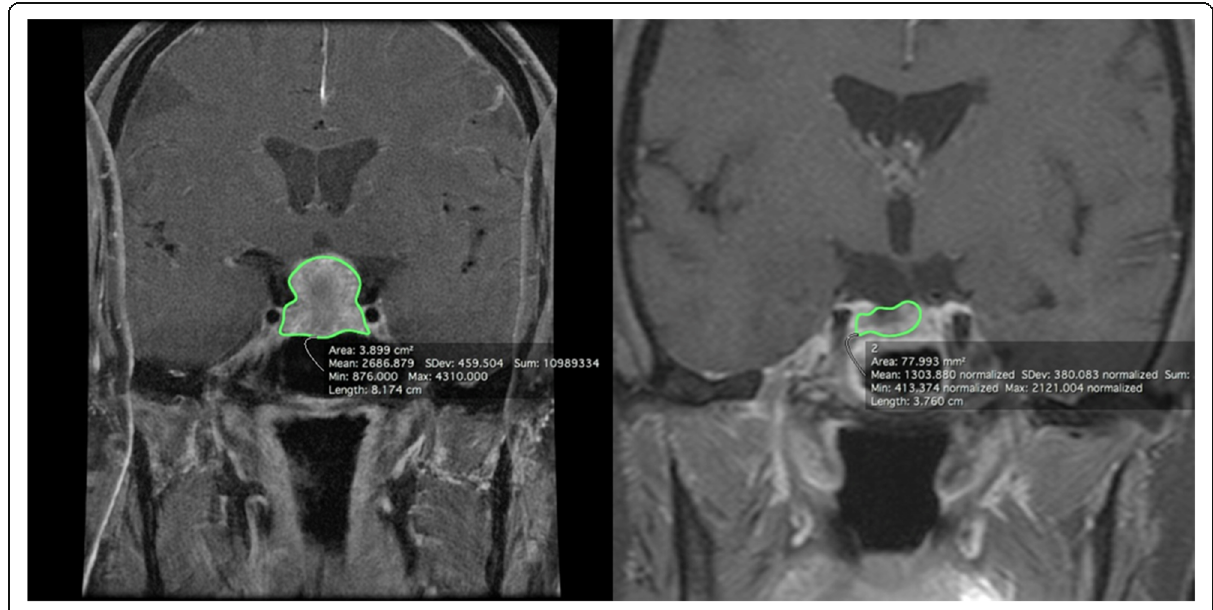
Fig. 2 A coronal contrasted T1-weighted MR image for a pre-operative tumor with a volume 5.56 cc, Knosp grade 3 (left) that was reduced to 0.44 cc (right) after endoscopic resection (92% volume reduction)